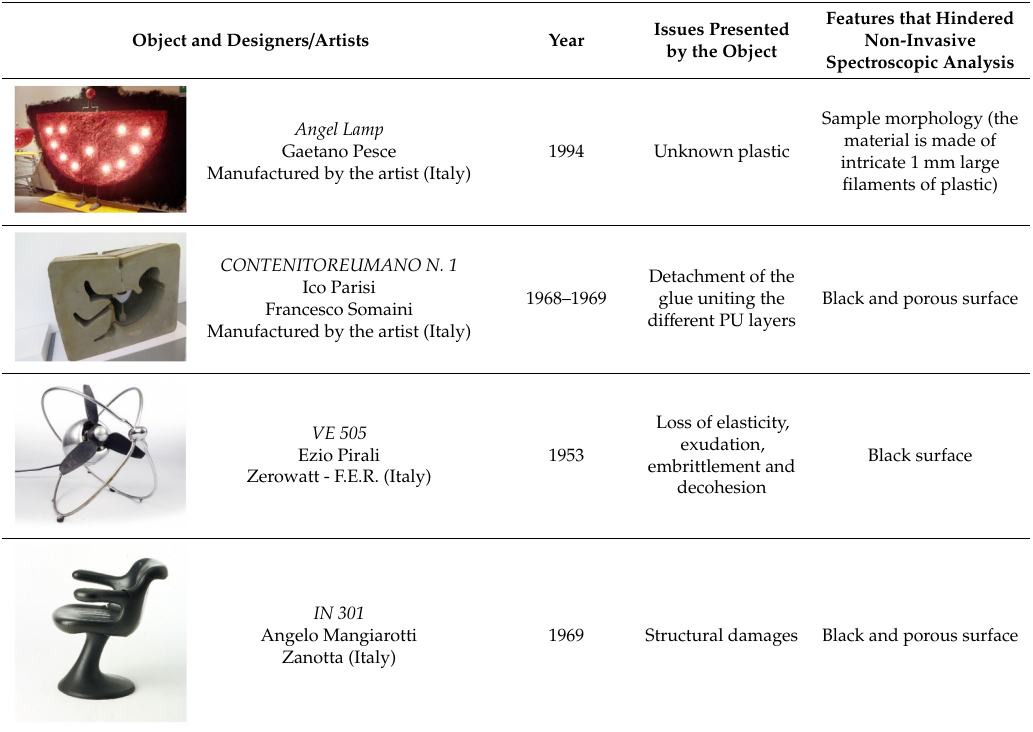
Table 1. A list of the design objects / artworks investigated, analytical issues preventing non-invasive characterization and conservation